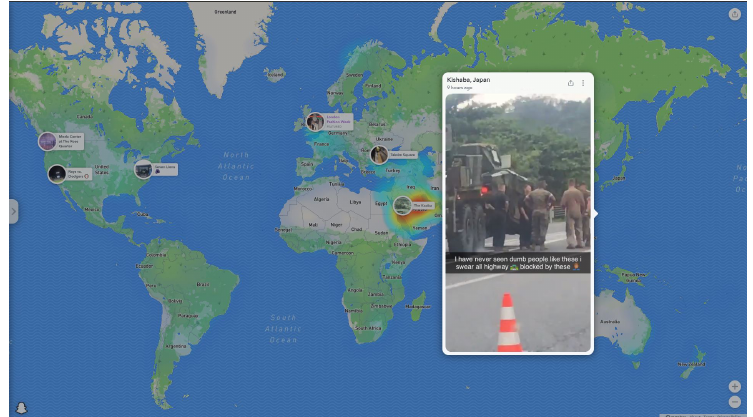
Figure 6. Accessing real-time military movement on Snapchat.